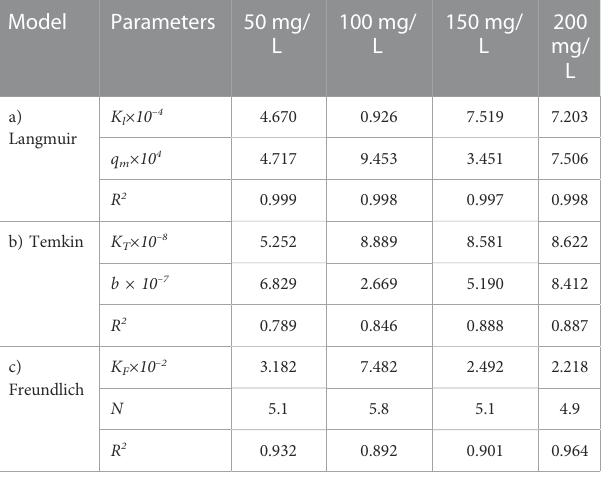
The italic values are parameters of the models.